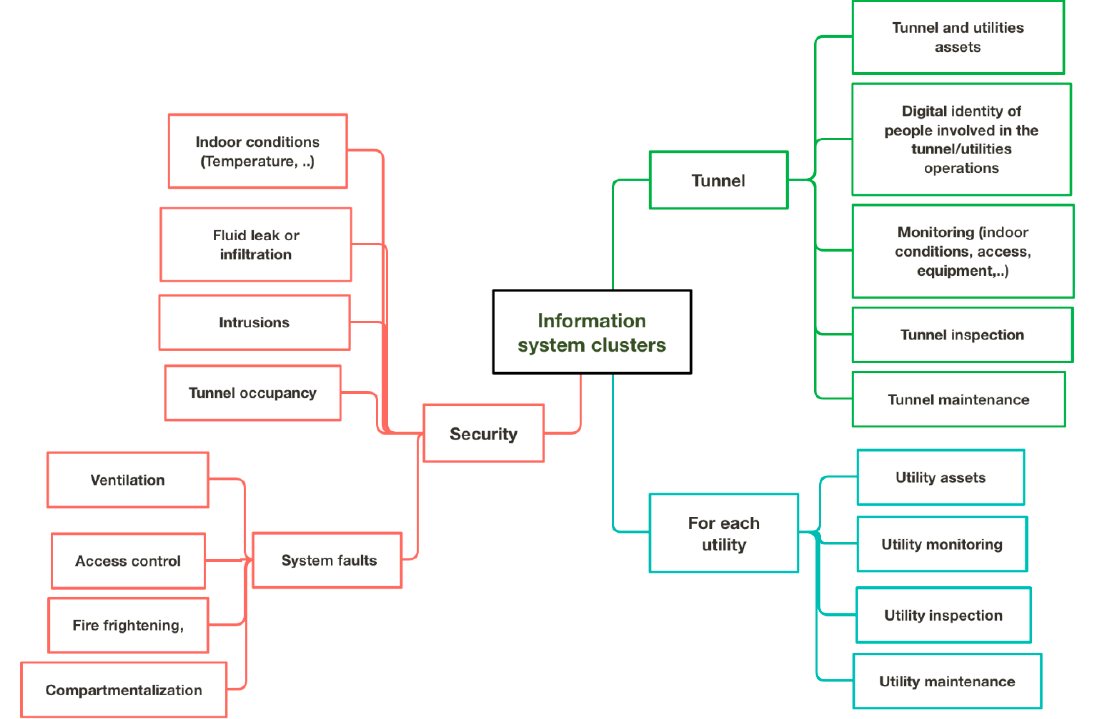
Figure 8. Data clusters in the information system.